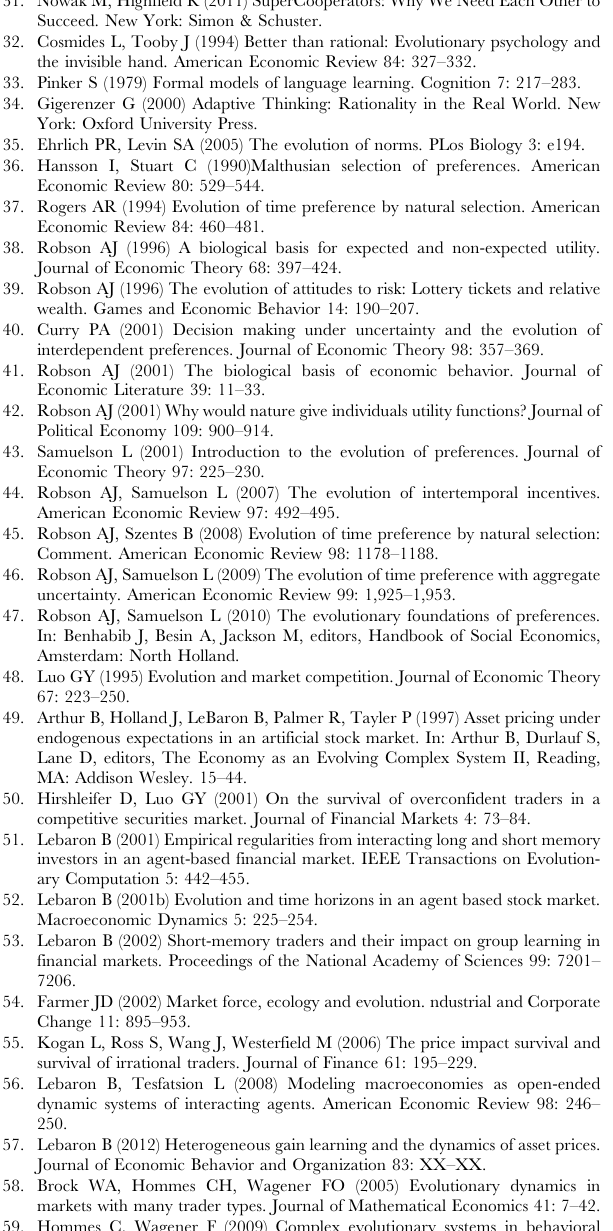
f (cid:2) ~ Q . On the line between the two large regions, any value for f (cid:2) between 0 and Q is optimal.